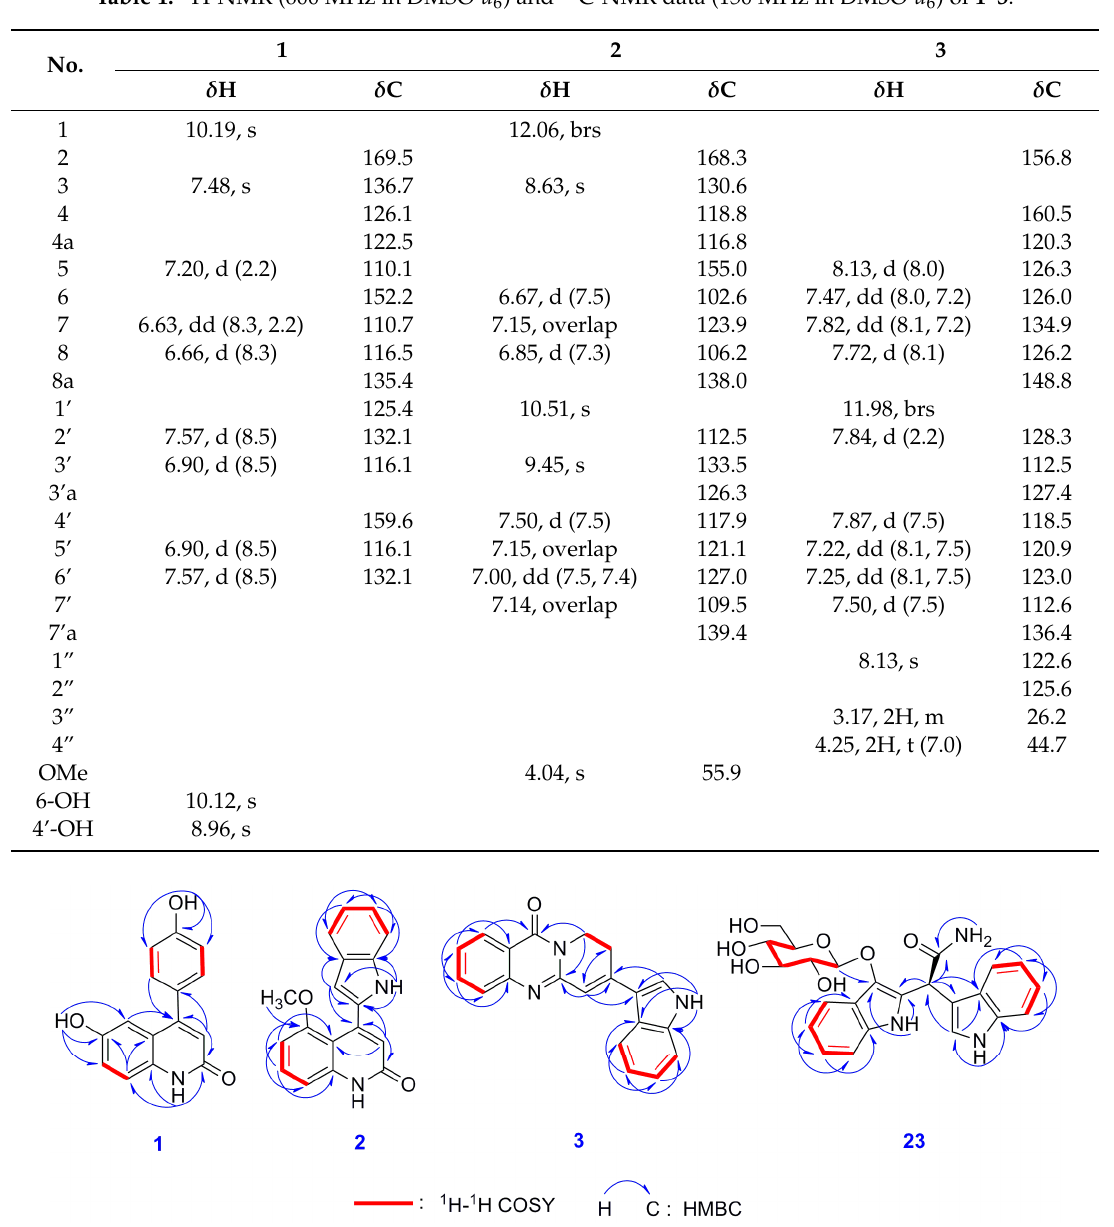
Figure 2. Key 1 H- 1 H COSY and HMBC correlations of Compounds 1 – 3 and 23 . Isatisindigoticanine F ( 2 ) was obtained as a yellow amorphous powder. The molecular formula was Table 1. 1 H-NMR (600 MHz in DMSO- d 6 ) and 13 C-NMR data (150 MHz in DMSO- d 6 ) of 1 – 3. assigned as C 18 H 14 N 2 O 2 by the one-dimensional-NMR data and the HRESIMS positive ion peak at m / z 291.1125 [M + H] + (calculated 291.1128 [M + H] + ). The 1 H-NMR spectrum (Table 1) of 2 showed signals of a 1,2,3-trisubstituted benzene ring at [ δ H 6.67 (1H, d, J = 7.5 Hz, H-6), 7.15 (1H, overlap,